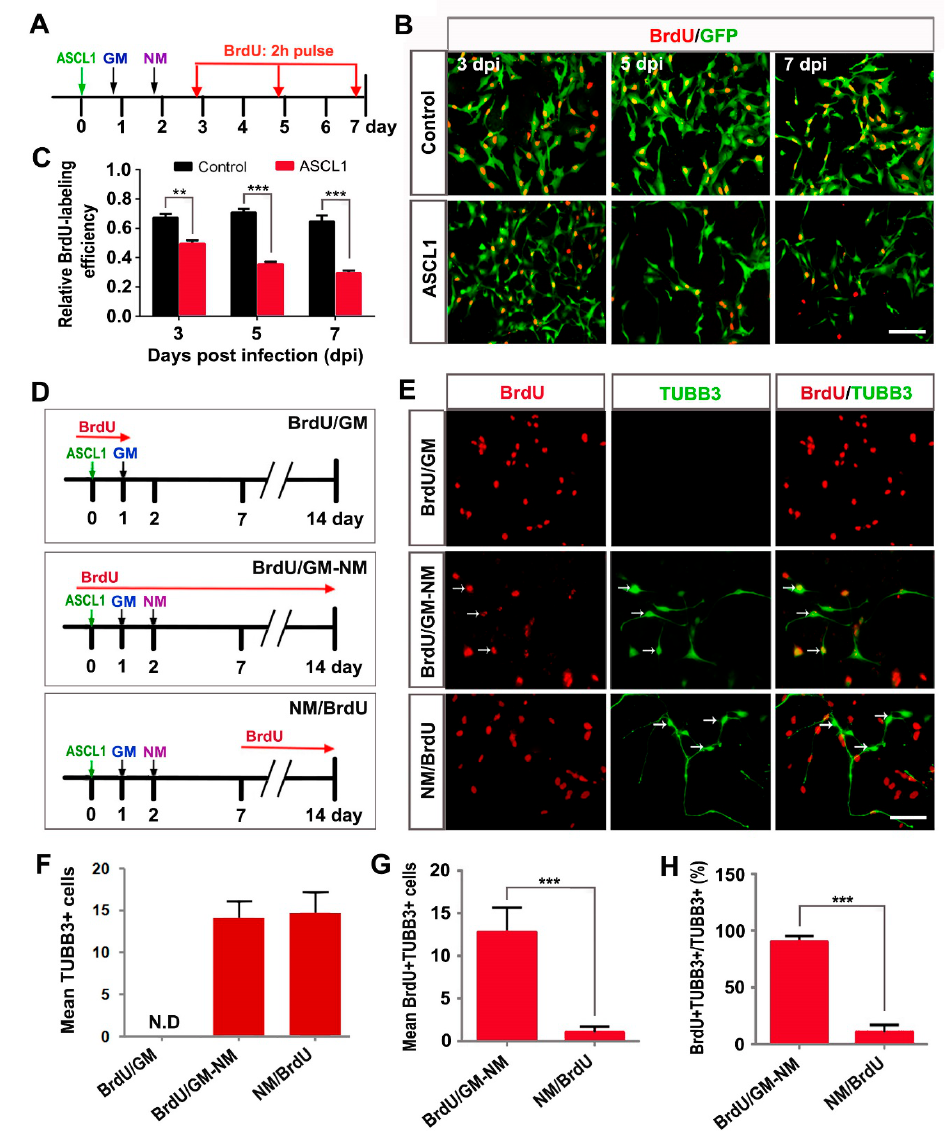
Figure 6. ASCL1-induced neuronal reprogramming results in cell cycle exit. ( A ) The experimental scheme for data presented in panels B and C. After virus infection, U251 cells were incubated with BrdU for two h before immunocytochemistry at the indicated time points. GM, growth medium; NM, neuronal induction medium. ( B ) and ( C ) Time-course analysis of proliferating cells after infection of U251 cells with ASCL1 or control GFP virus (n = 20 randomly selected fields from three independent experiments; ** P < 0.01, *** P < 0.001 by Student’s t -test). (D) The experimental scheme for data presented in panels E-H. U251 cells were infected with ASCL1-expressing virus and treated with BrdU for the indicated periods of time. ( E )–( H ) Quantitative analysis of reprogrammed cells and cell proliferation (n = 20 randomly selected fields from triplicate samples; *** P < 0.001 by Student’s t -test). ASCL1 induced no neuron-like cells under the growth medium (GM) condition. The neuronal survival was not affected by continuous incubation with BrdU (BrdU/GM-NM). ASCL1-induced neuronal reprogramming led to rapid cell cycle arrest (NM/BrdU). The “mean number of cells” refers to the average number of cells per field of view. Arrows indicate BrdU + TUBB3 + cells. N.D, not detected. Scales: 100 μ m ( B and E ). To determine whether ASCL1-induced cell cycle exit contributed to inhibiting the glioma cell growth, immunocytochemistry and quantitative analysis were performed. As an endogenous marker for proliferating cells, Ki67 staining was used to assess the growth of glioma cells after